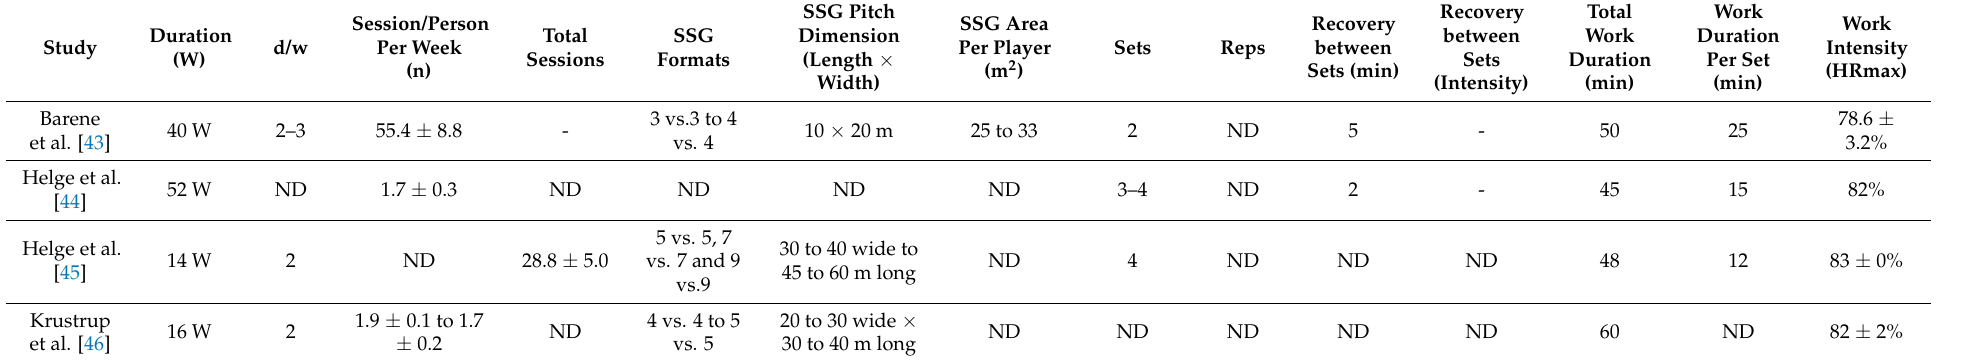
Table 3. Characteristics of small-sided games (SSG)-based programs in the included